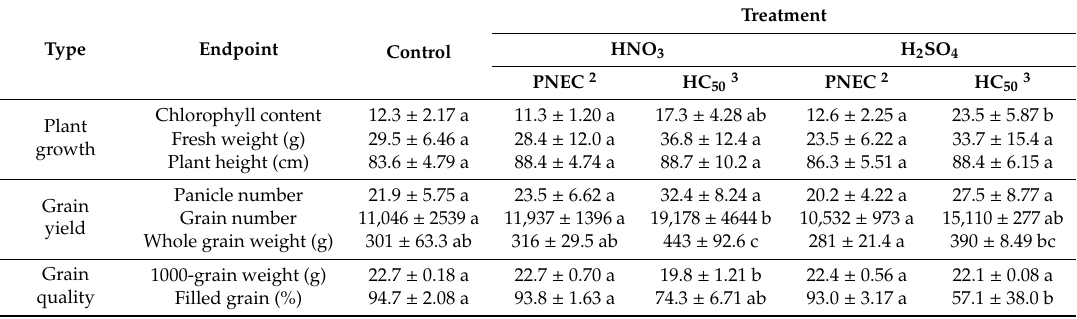
Table 2. Results 1 of rice growth and yield / quality attributes of the harvested rice measured at the 20th